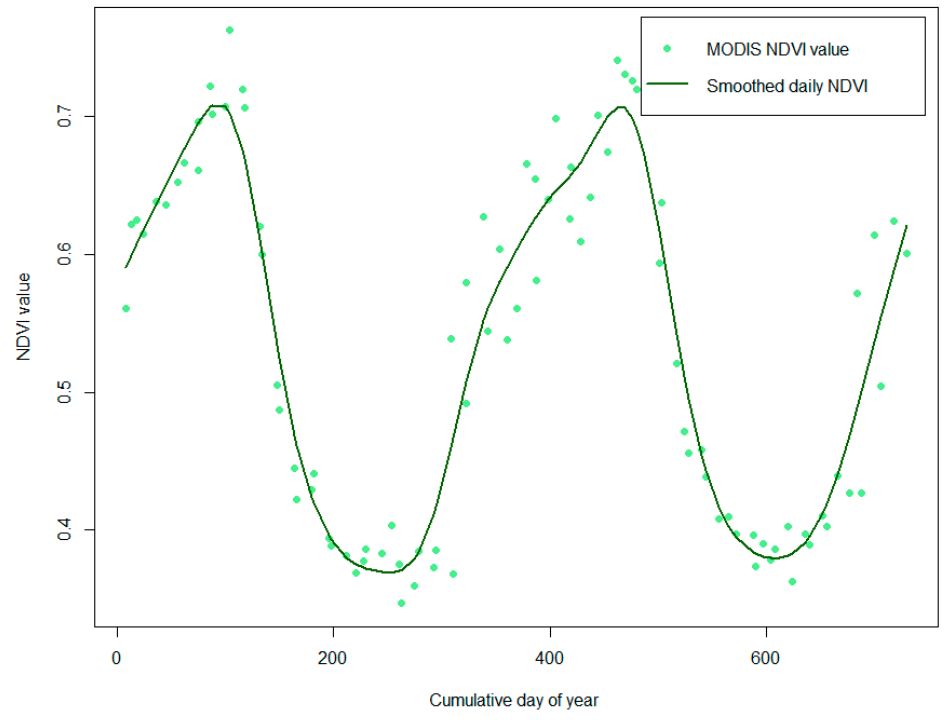
Figure 4. An example of the fitted cubic smoothing spline for NDVI temporal gap filling for the period 2016-2017.